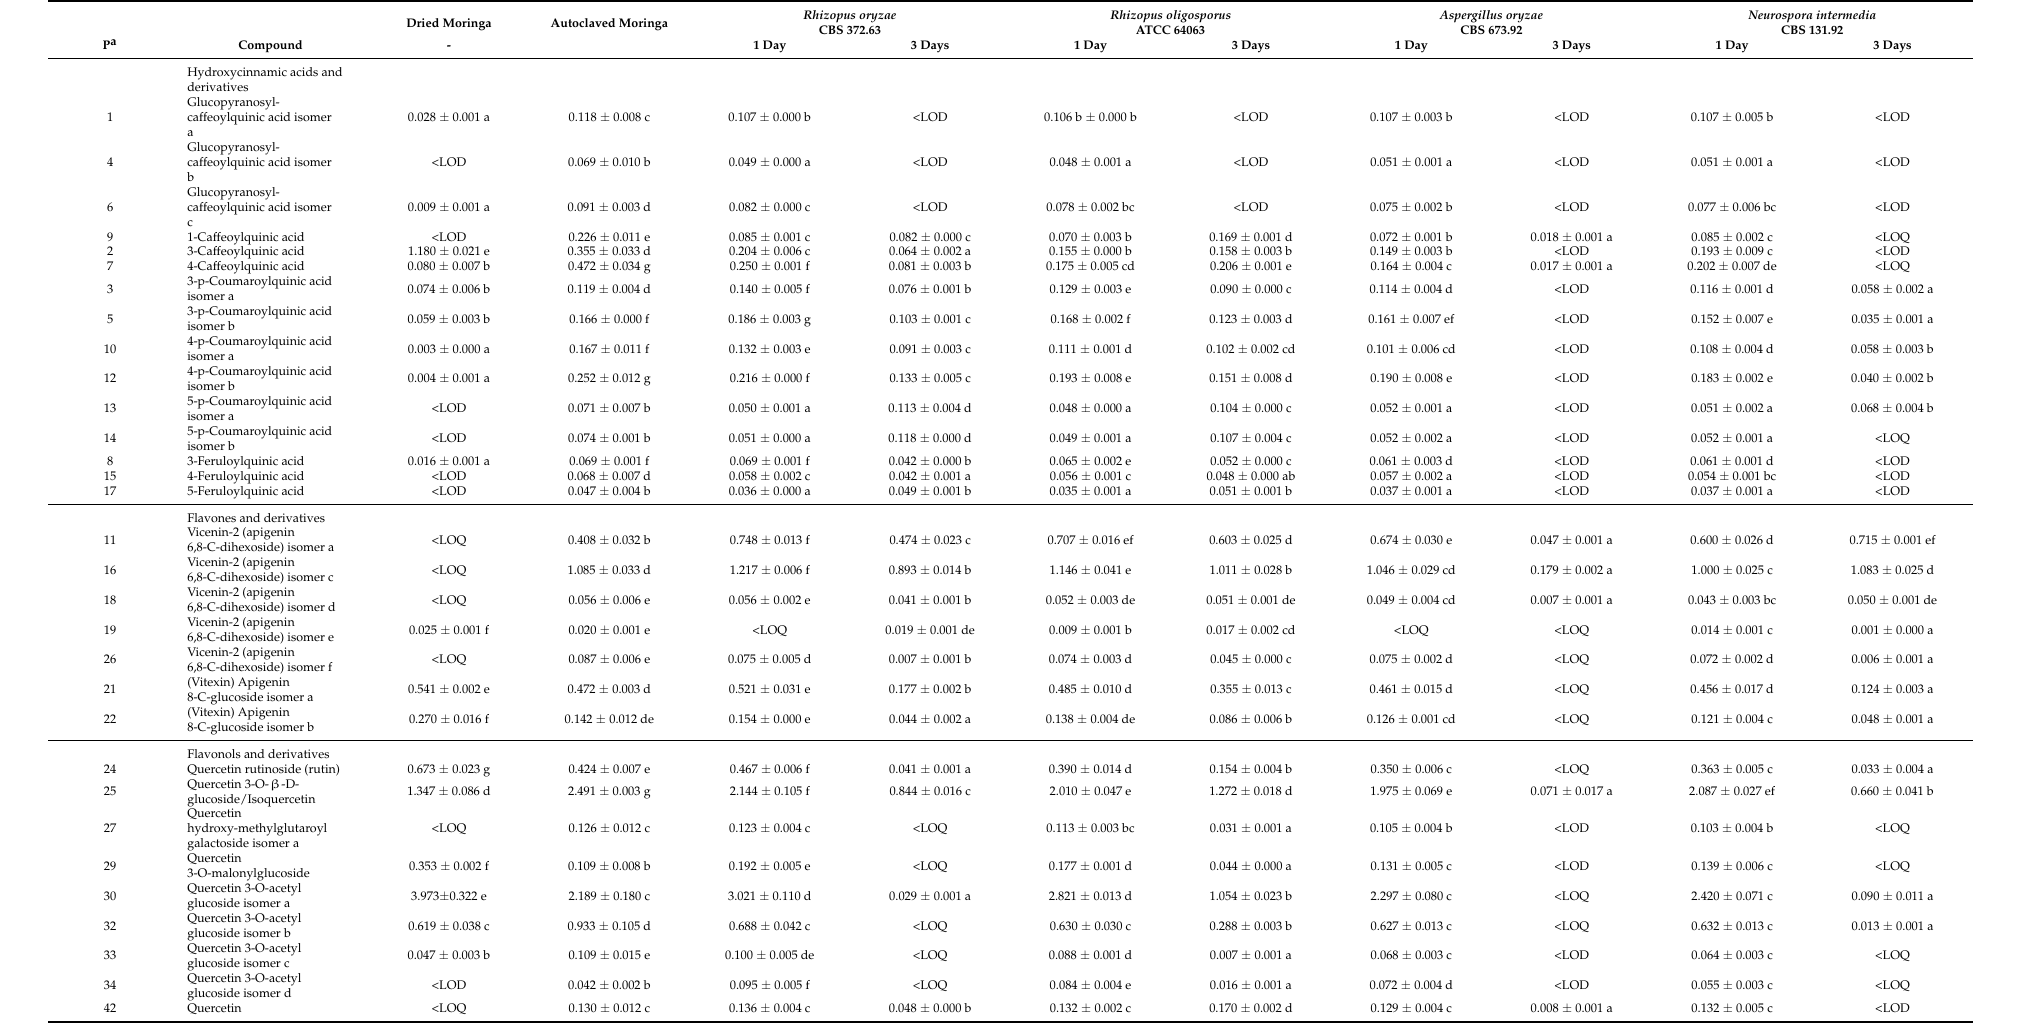
Table 2. The quantification of phenolic compounds (mg/g DM) in moringa leaves—dried, autoclaved, and fermented—with the studied microorganisms at each time of fermentation (1 and 3